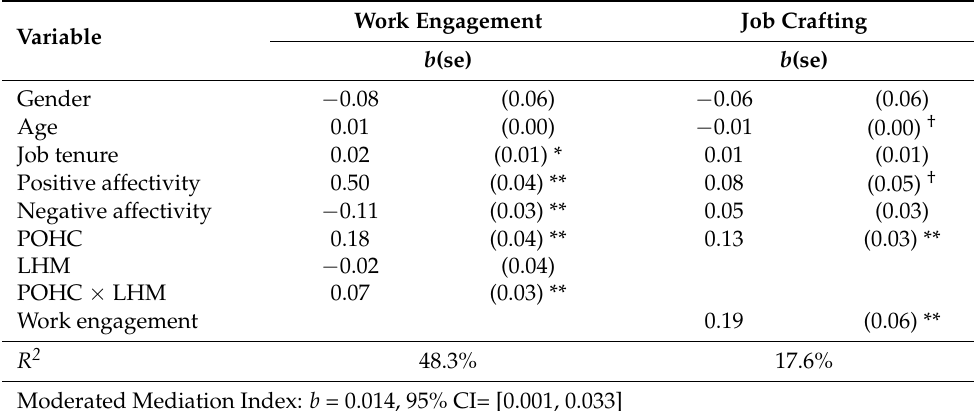
Table 4. Results for the moderation of LHM on work engagement and job